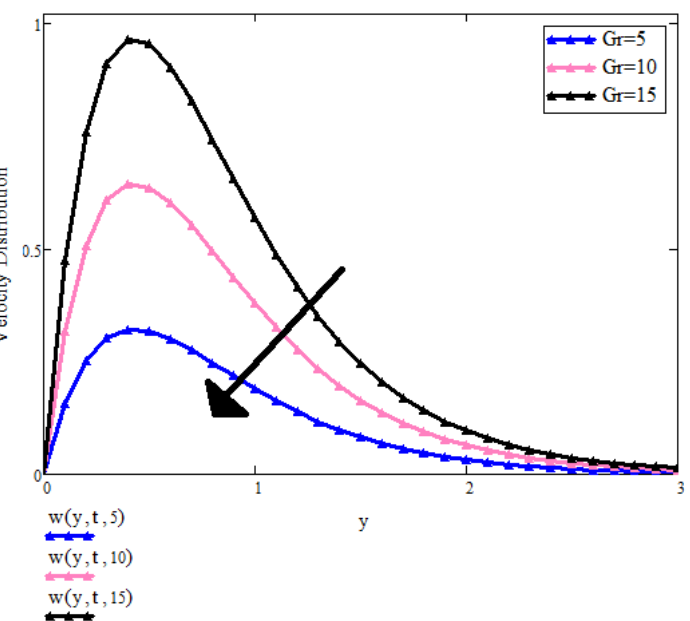
Figure 8. u ( y , t ) with Gr when t = 1, a = 0.9, λ = 0.5, λ 2 = 0.9, Pr = 6.2, β 1 = 0.9, φ 1 = φ 2 = φ 3 = 0.05.